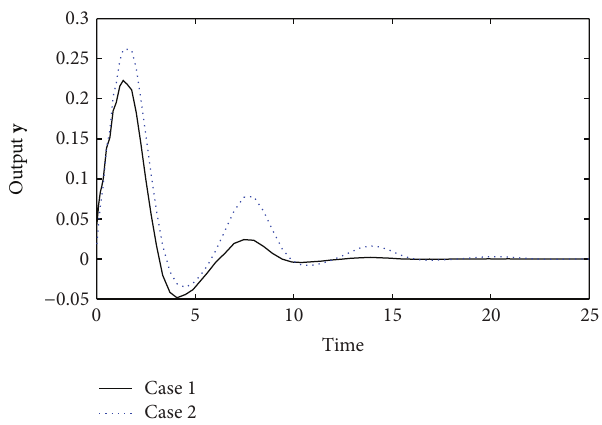
Figure 4: The trajectories of the controlled system output y (𝑡) .